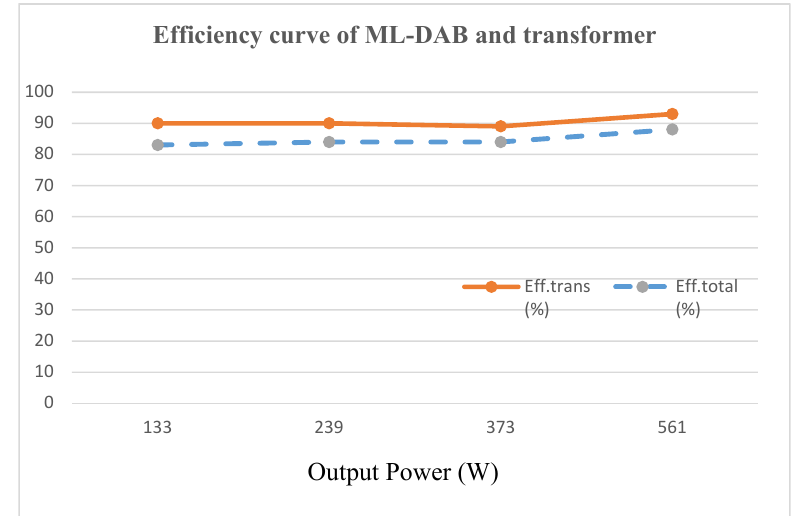
Figure 25. Efficiency curve of the transformer and ML-DAB with output power